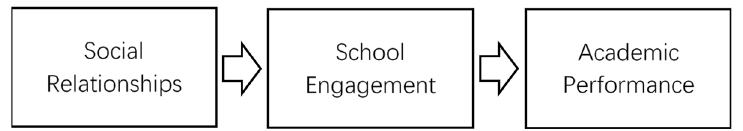
framework of social relationships and